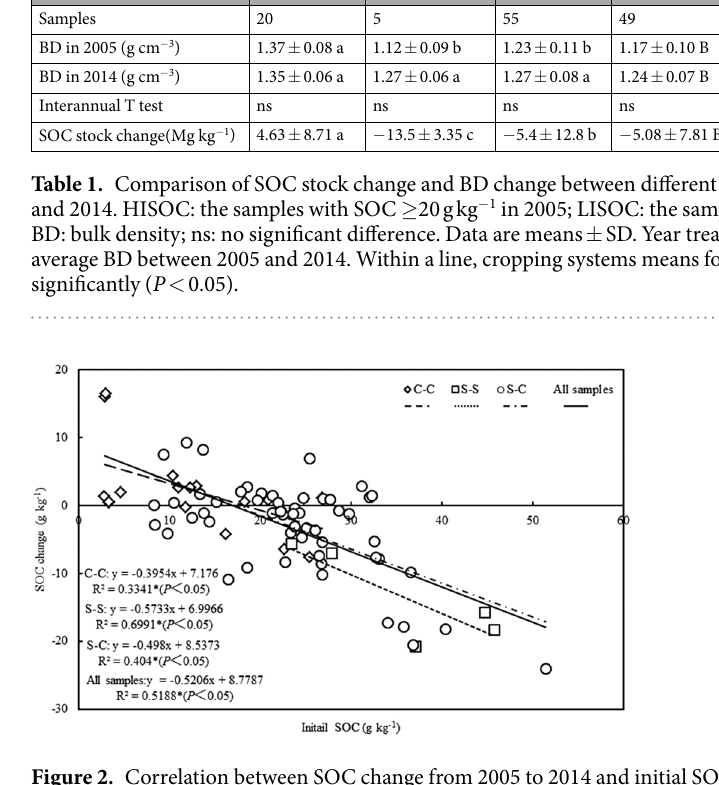
Figure 2. Correlation between SOC change from 2005 to 2014 and initial SOC in 2005. Each point represents the data collected from one farmer field site. Triangle indicated C-C systems (n = 20). Square indicated S-S systems (n = 5). Circle indicated S-C systems (n = 55). Asterisk is significantly different ( P <